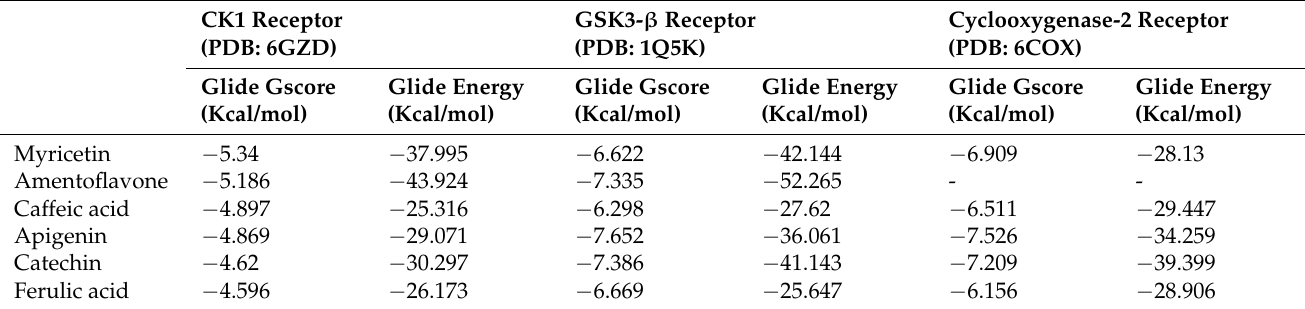
Table 6. Molecular docking with ligands in the CK1, GSK3- β , and cyclooxygenase-2